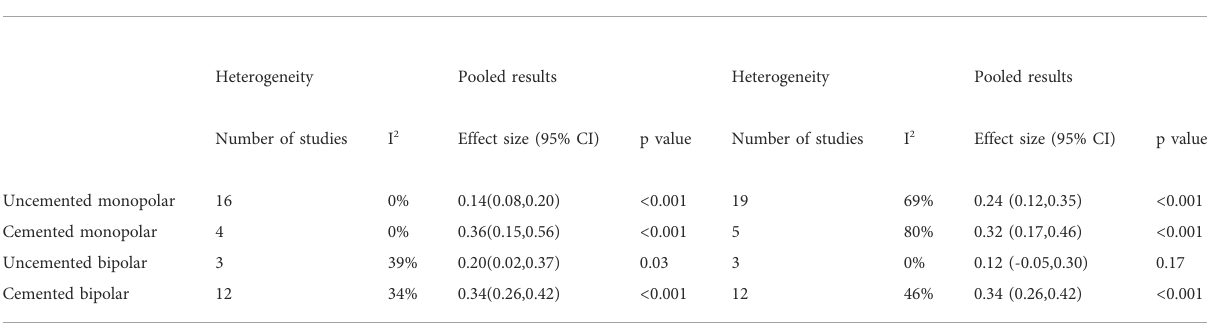
TABLE 3 Meta-analysis for secondary